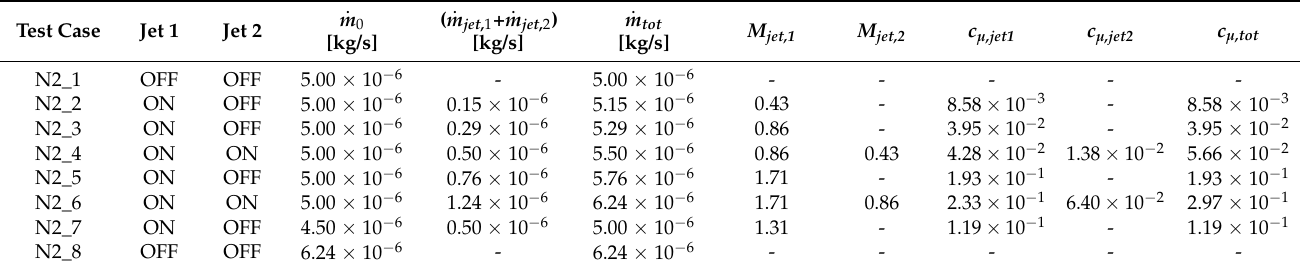
Table 6. Test matrix and micro-jet blowing conditions: nitrogen gaseous flow. Jet temperature T jet1 = T jet2 = 293 K. Test Case Jet